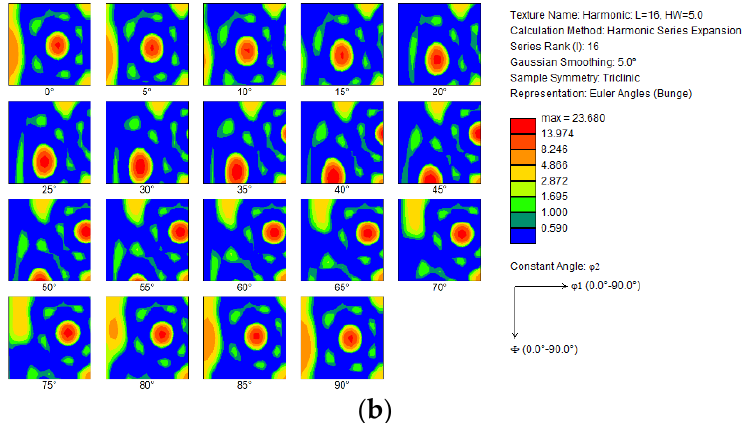
Figure 6. Micro − texture of AA7075 in its initial state. ( a ) IPF; ( b ) ODF.